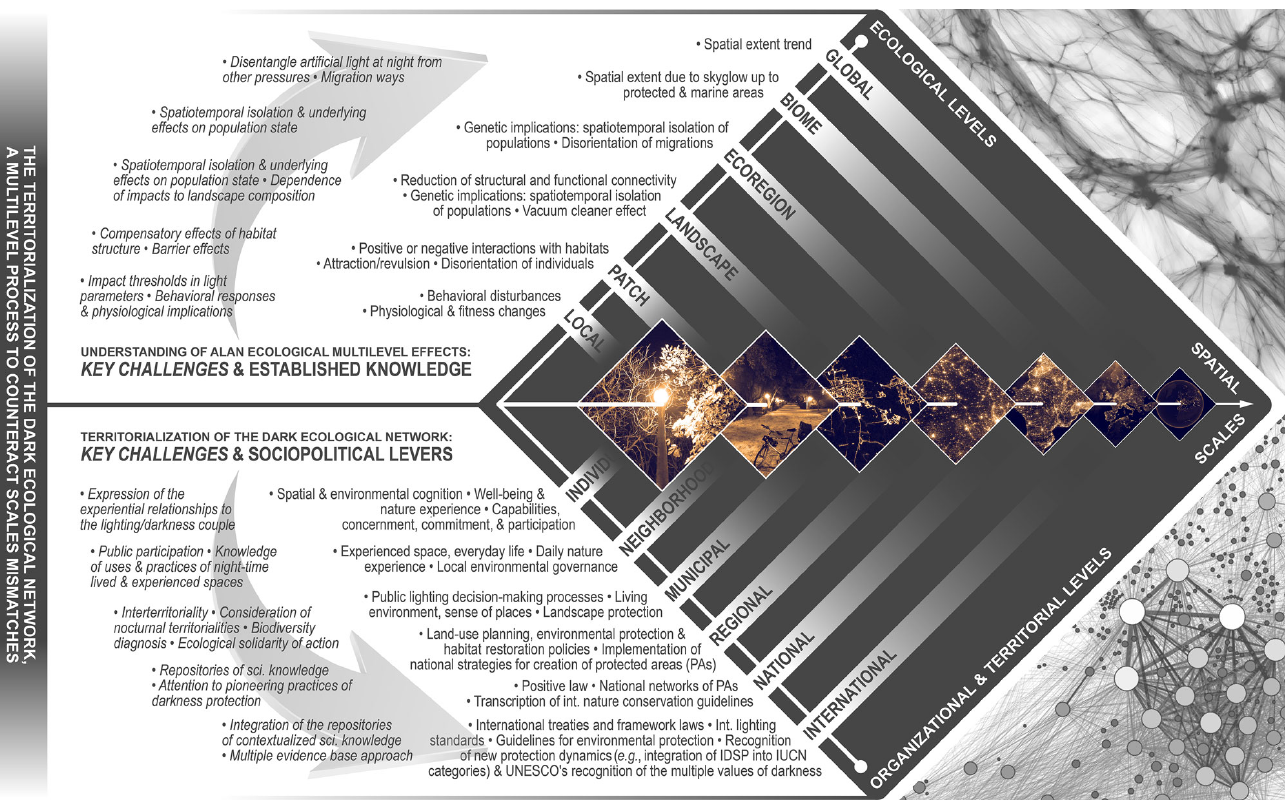
Fig. 1 . Synthesis diagram pointing out the multilevel effects of ALAN and the challenges of articulating organizational levels for a bottom-up approach of the dark ecological